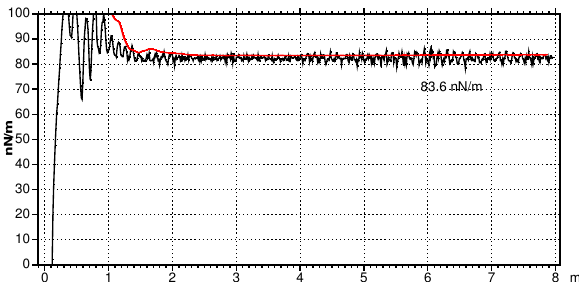
Figure 16. Run V1000Bx: V w = 856 . 07V, B x = 30 000nT and 8ms duration.